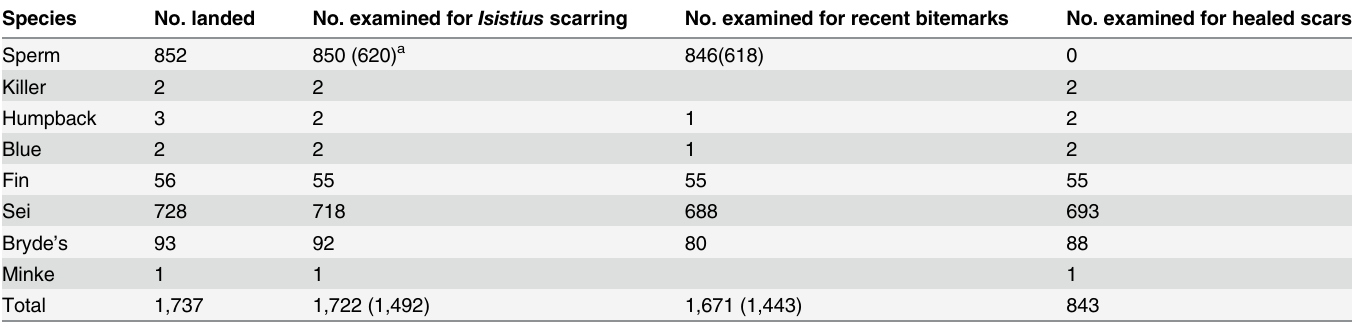
Table 1. Whales examined at the Donkergat whaling station, South Africa, 1963 Species No. landed No. examined for Isistius